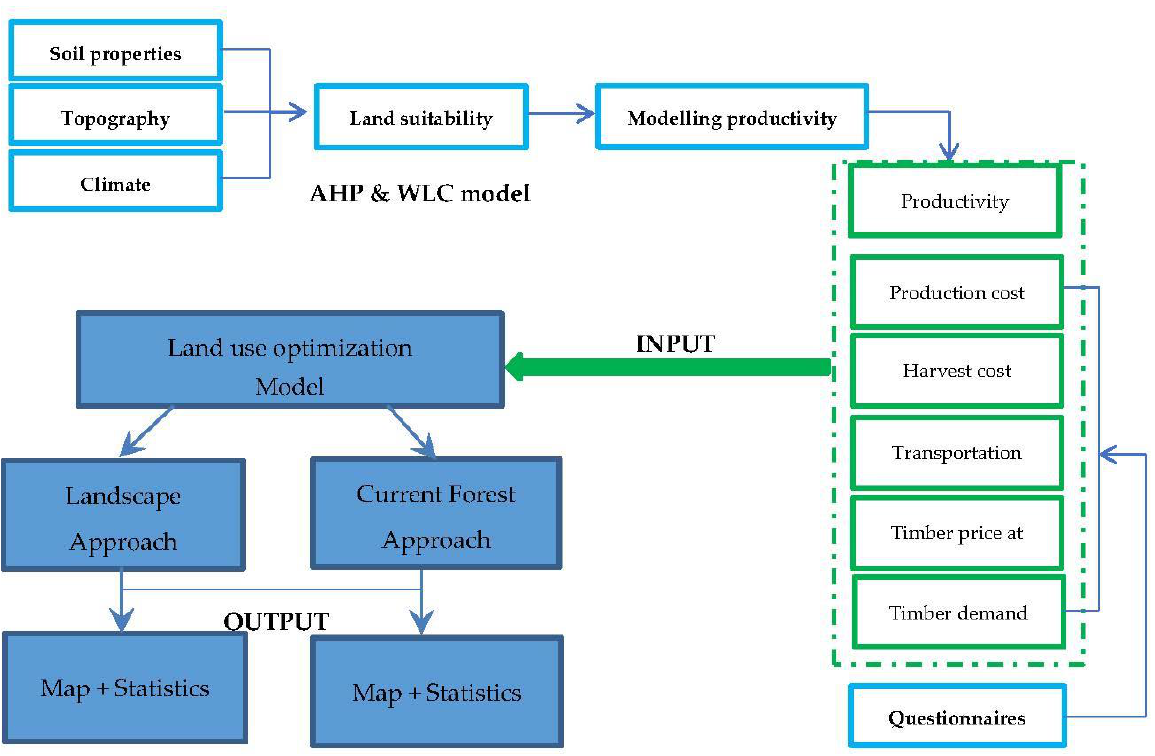
Figure 3. Framework of the land-use optimization model.